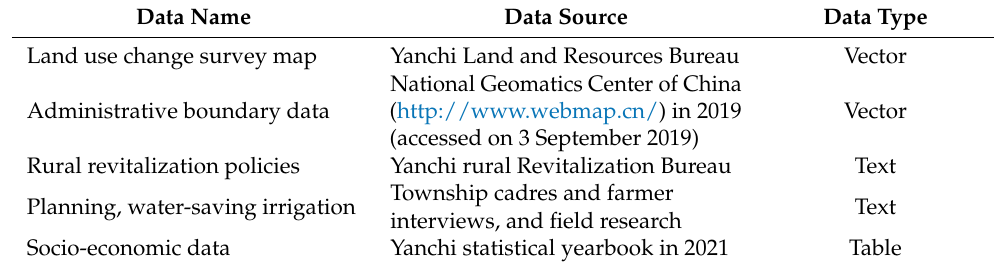
Table 2. Data sources and description.